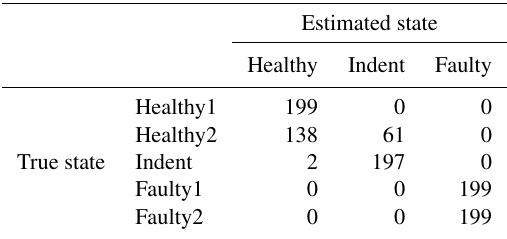
Figure 12. Scatterplot of top two features for the 3000rpm MEMS dataset.